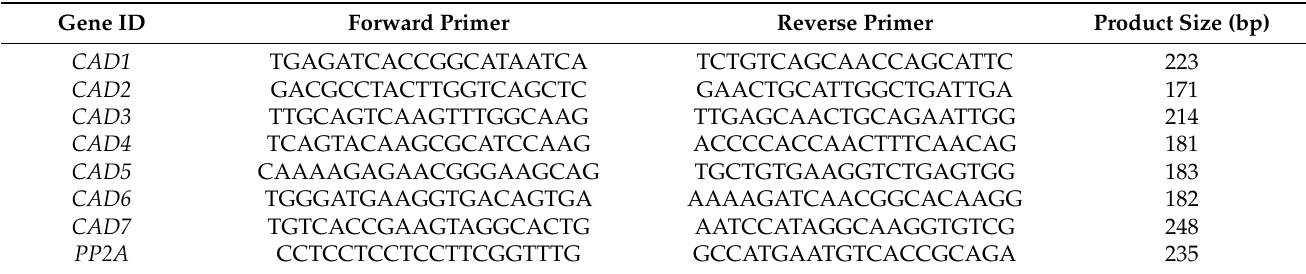
Table 1. Conserved primers used for qRT-PCR analysis in five agave species.